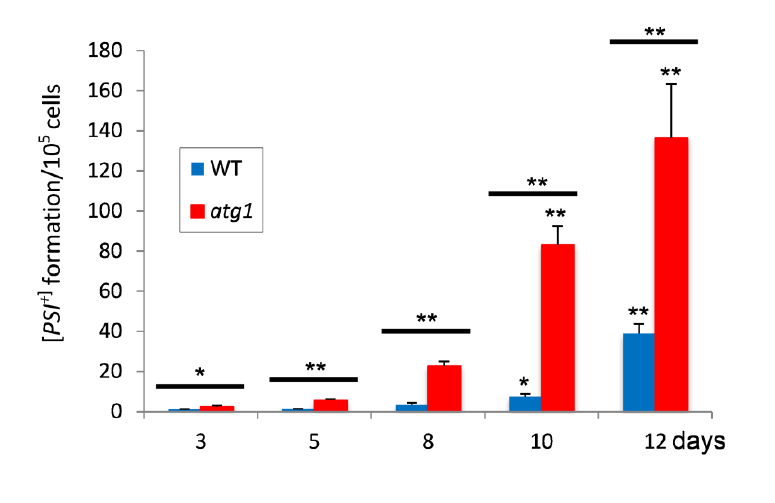
FIGURE 1: Increased frequency of [ PSI + ]